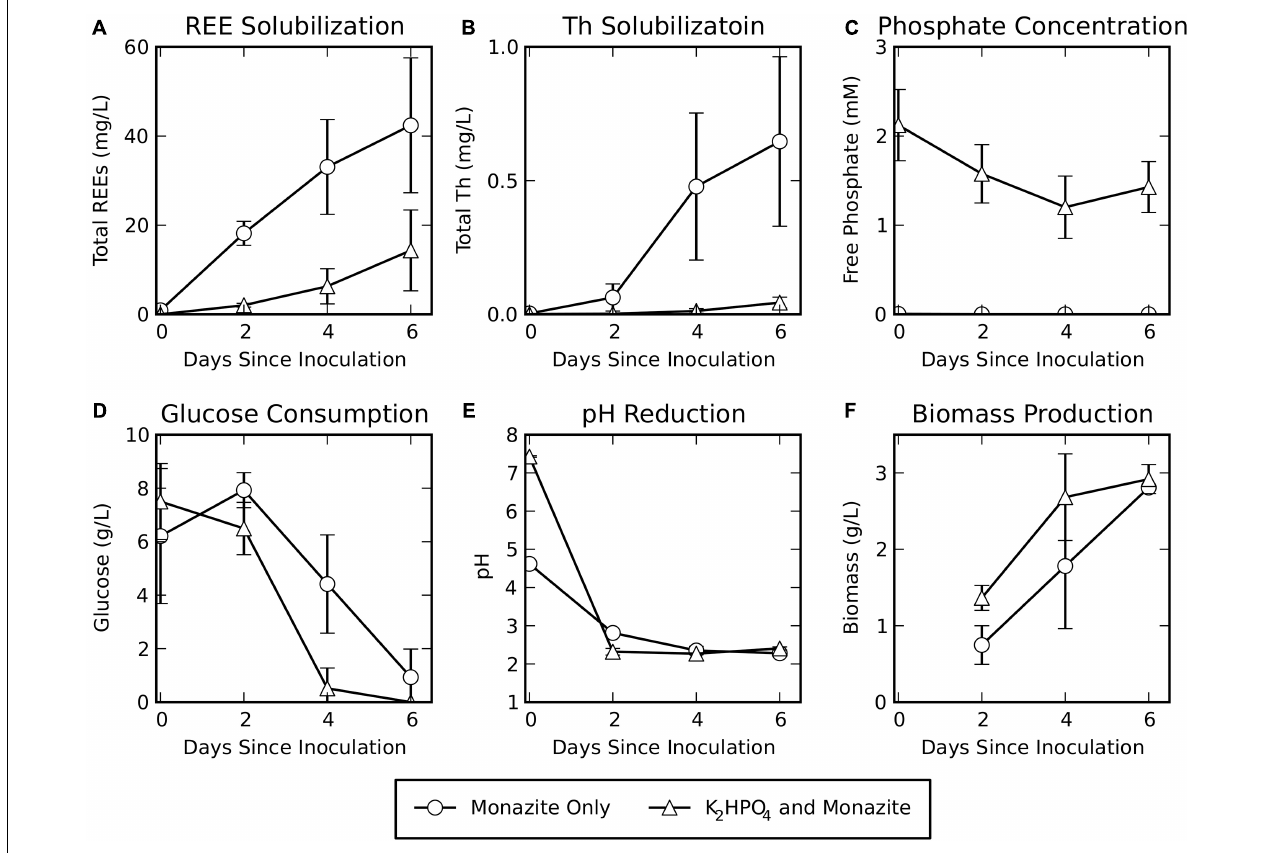
FIGURE 1 | Bioleaching of monazite in the absence or presence of soluble phosphate (K2HPO4). Shown are (A) REE concentrations, (B) Th concentrations, (C) phosphate concentrations, (D) glucose concentrations, (E) pH, and (F) biomass measured as volatile solids. REE, phosphate, glucose, and pH data are for six biological replicates. Biomass data are for three biological replicates. Error bars indicate standard deviations around the